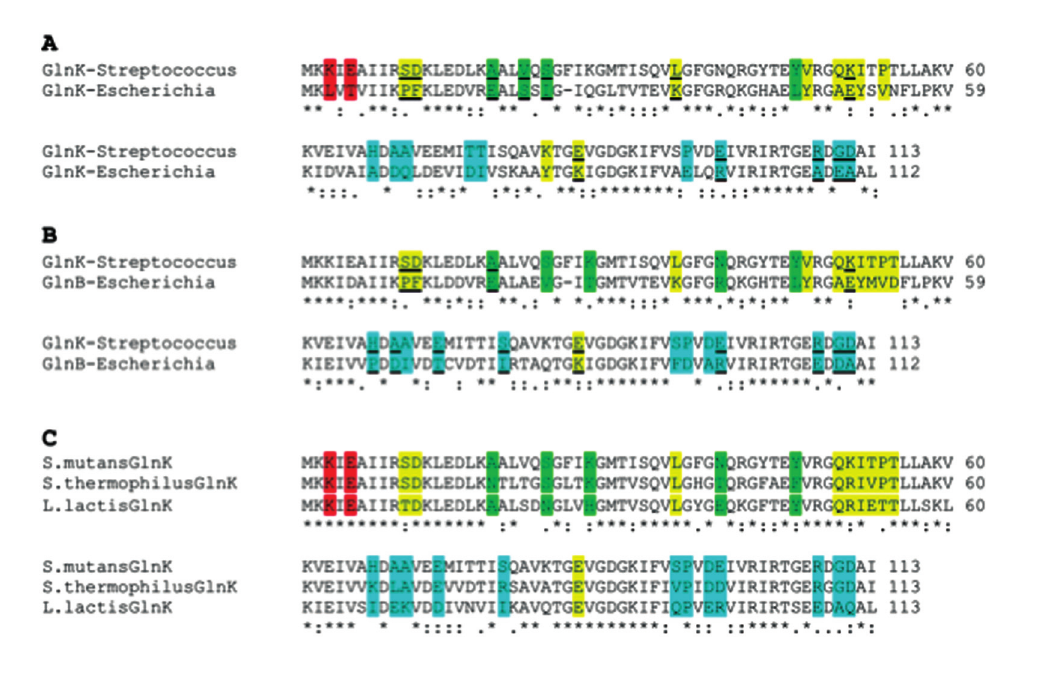
Figure 5. Alignments of the Streptococcus mutans GlnK and other organisms PII-like proteins. A , Alignment of S. mutans GlnK and Escherichia coli GlnK. B , Alignment of S. mutans GlnK and E. coli GlnB. C , Alignment of Streptococcus mutans GlnK, S. thermophilus GlnK and Lactobacillus lactis GlnK. The protein sequences were obtained from NCBI and the alignments were performed with Clustal X (40). Yellow = residues on the top surface; green = residues on the side surface; blue = residues on the bottom surface; red = residue towards the central cavity of PII proteins. The underlined residues indicate the change in the polarity of the